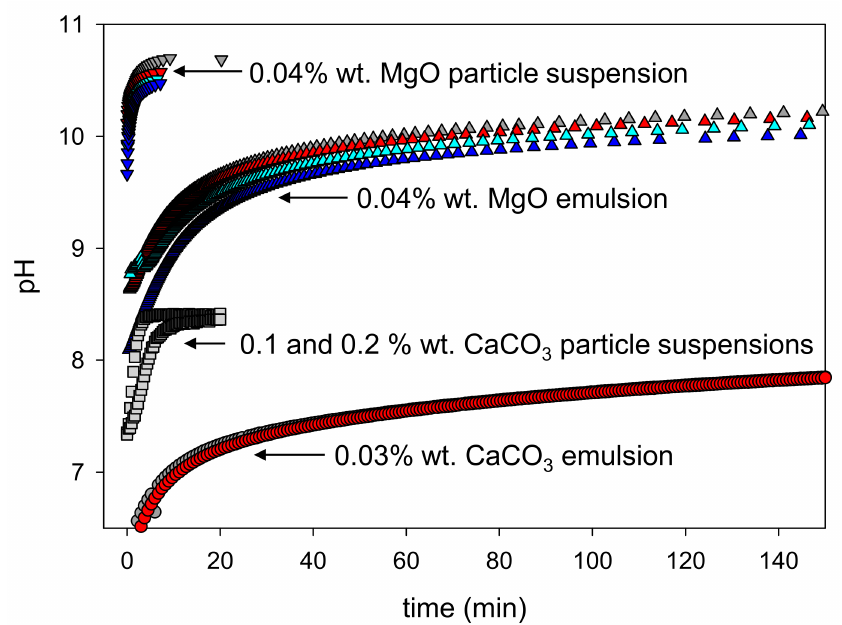
Figure 2. Measured pH during alkalinity release experiments that used repeated additions of HCl. Note that the temporal resolution of the data gives the illusion of a line, but all information shown in this figure is in the form of discrete measurements. Colors denote order of pH rebounds: first grey, second red, third cyan, fourth